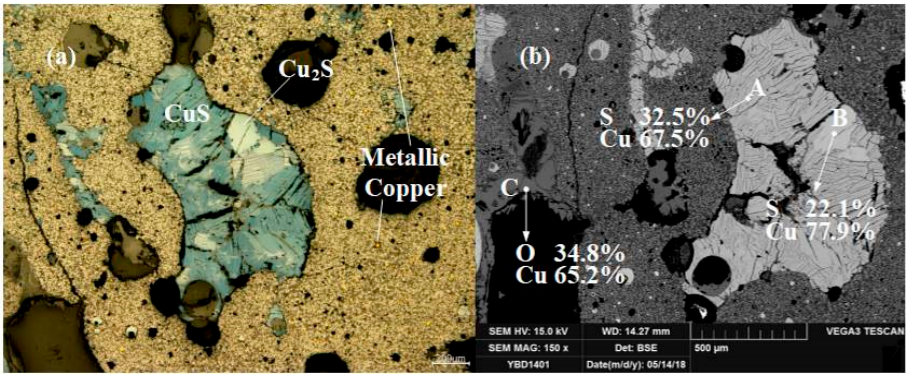
Figure 20. Optical micrograph ( a ) and SEM backsca tt ered electron image ( b ) of YBD14. Sample YBD15: Copper particles coated by Cu 2 O (cuprite) could be detected under a